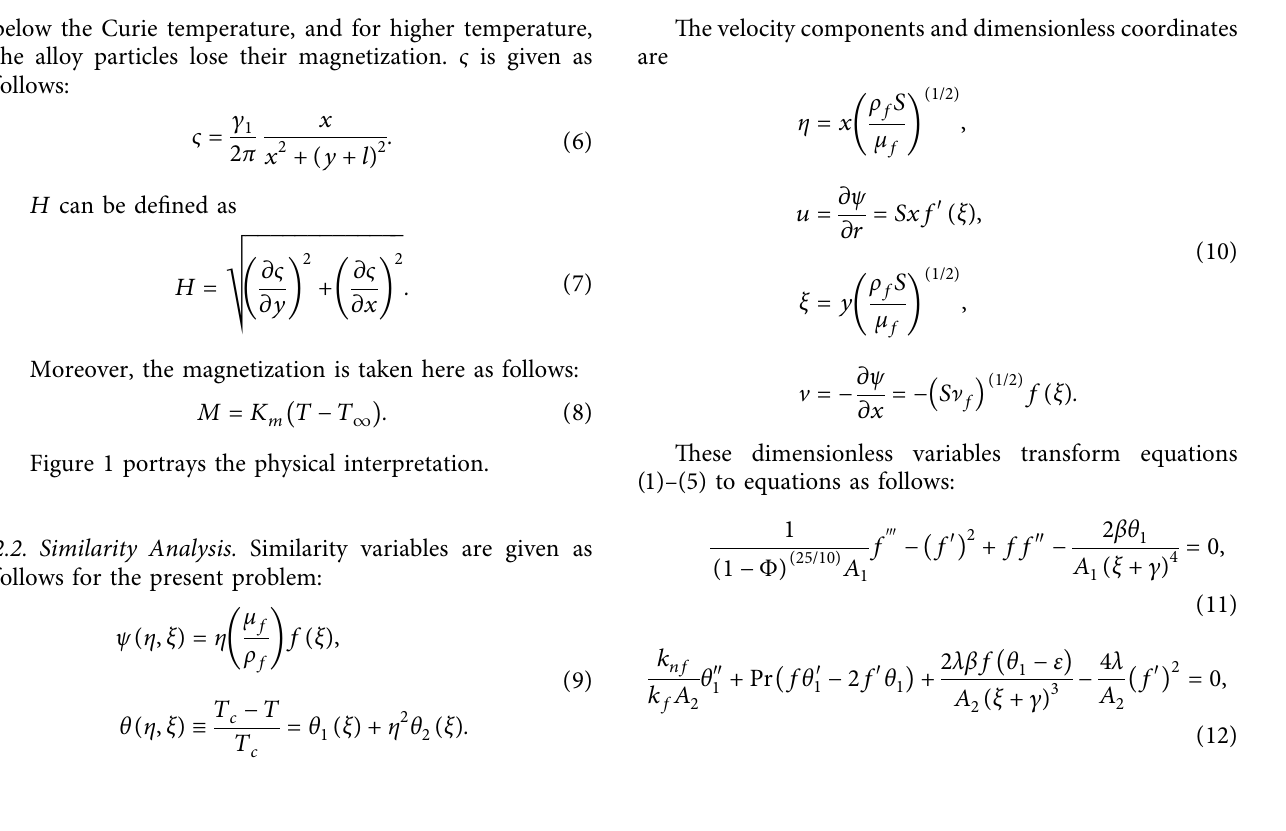
H and magnesium alloy MgZn 8 18